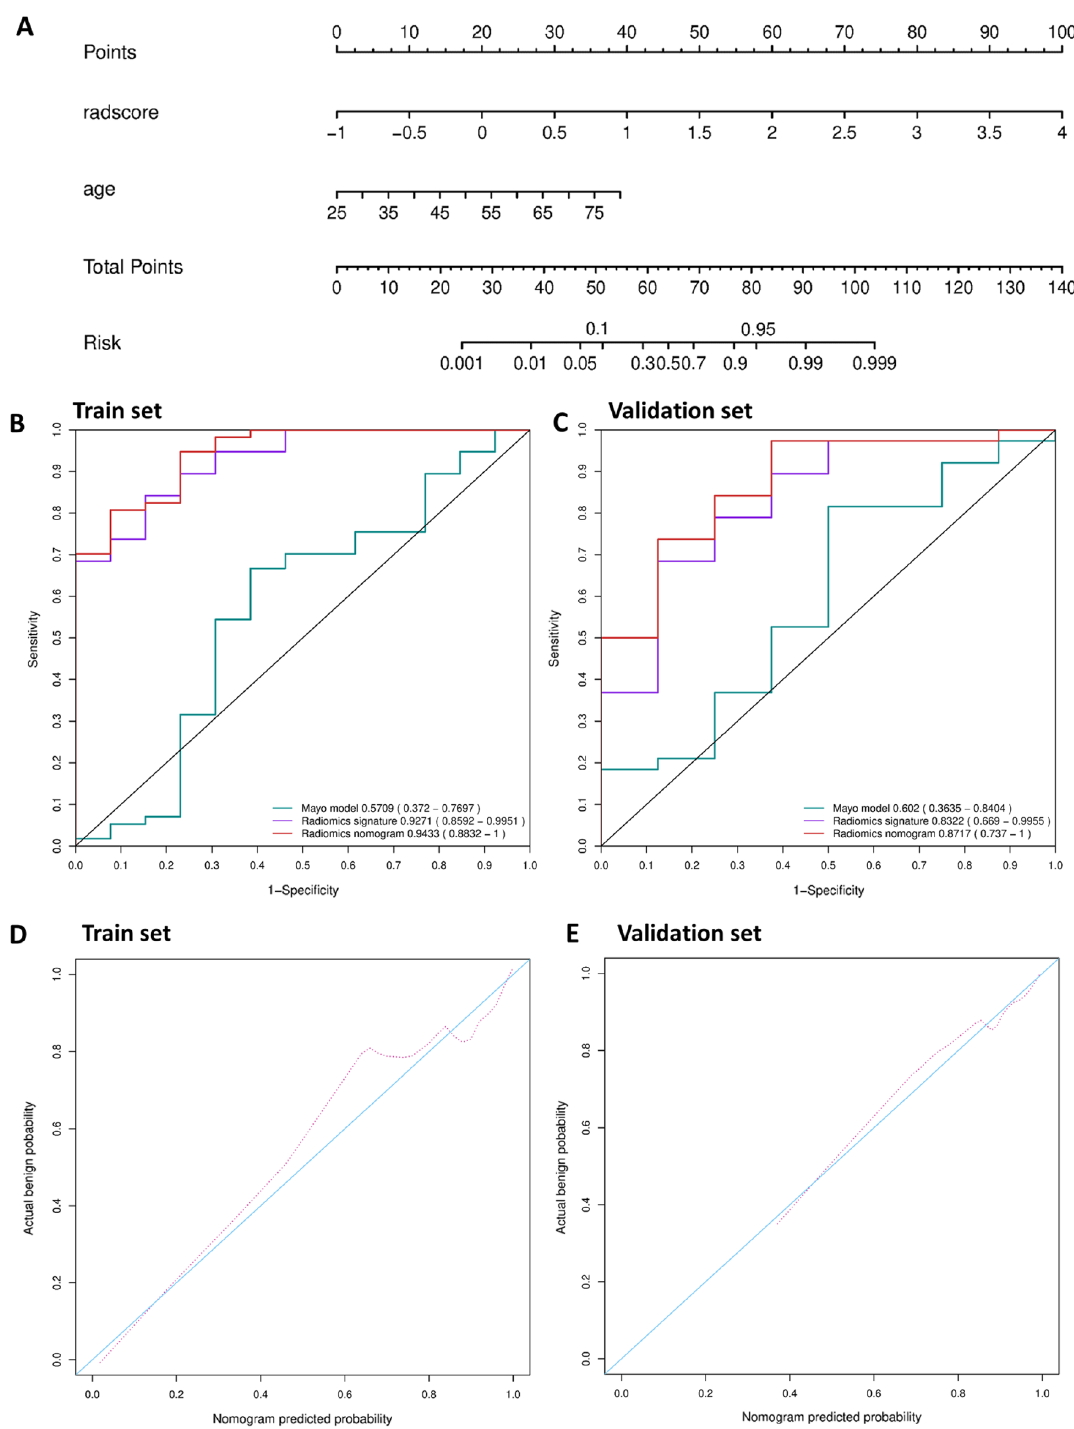
Figure 4. Radiomics nomogram for the prediction of benign and malignant early-stage SPNs. ( A ) A radiomics nomogram of the two predictors was constructed. ( B ) The AUC of 0.9433 (95% CI 0.8832–1) revealed good discrimination by the nomogram. ( C ) The AUC of the validation set was 0.8717 (95% CI 0.737–1). ( D ) The calibration curve and a nonsignificant Hosmer–Lemeshow test statistic ( P = 0.9742) showed good calibration in the training set. ( E ) The Hosmer–Lemeshow test yielded a nonsignificant P value of